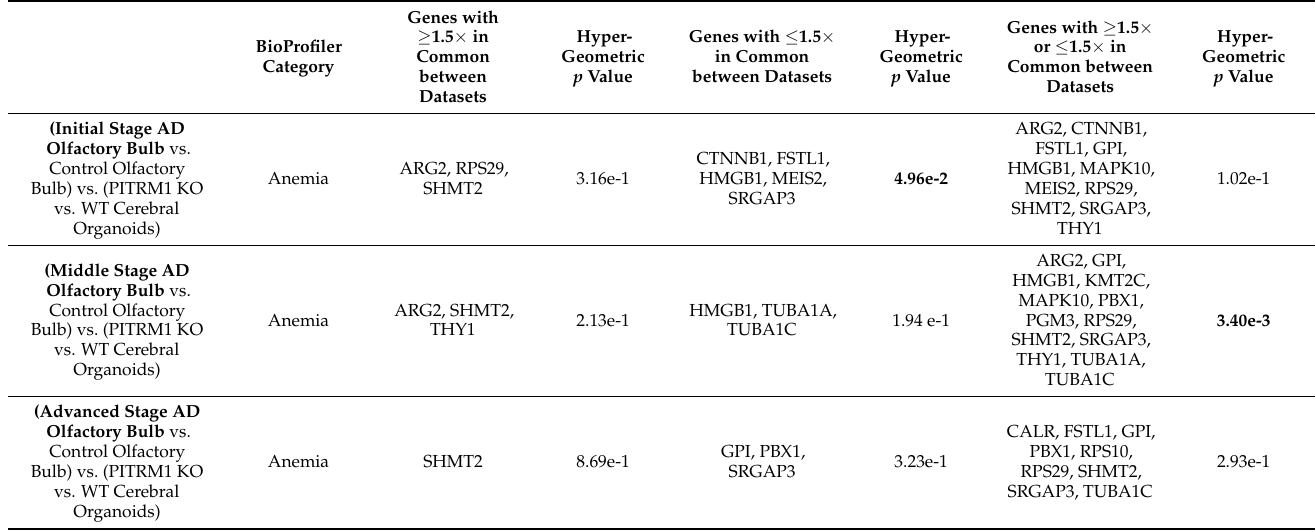
Hyper- Genes with ≤ 1.5 × Geometric in Common p Value between Datasets